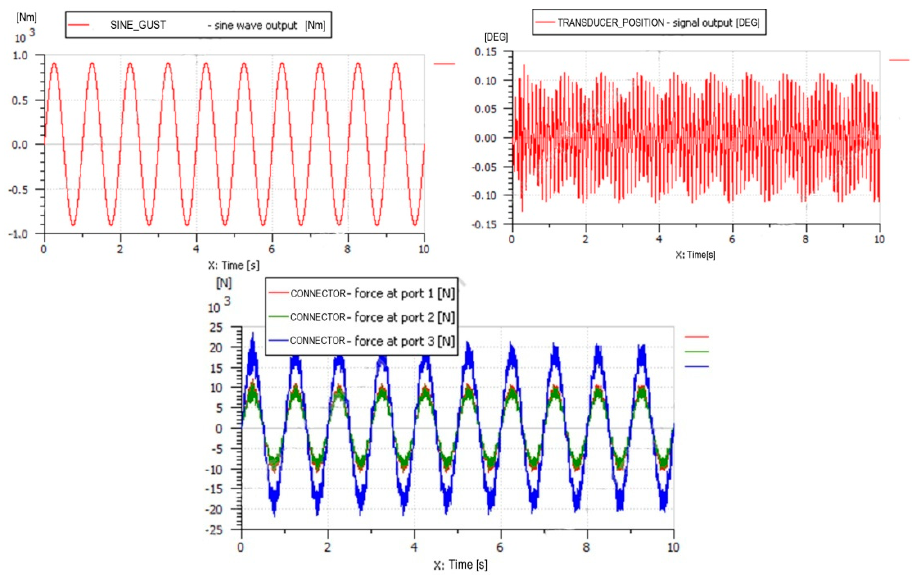
Figure 10. System behavior with sinusoidal gust.